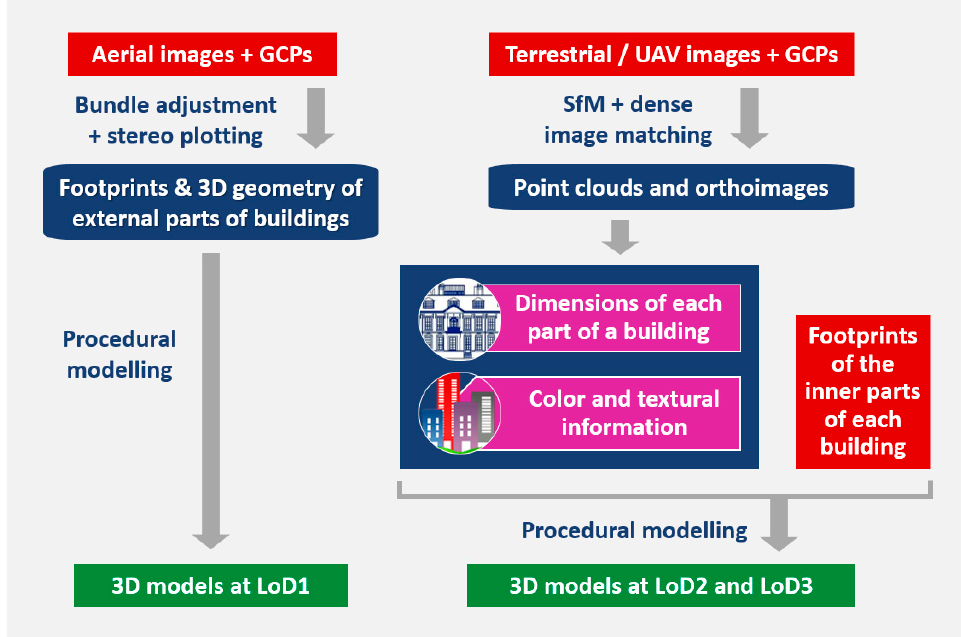
Figure 1. 3D modeling framework of the existing situation at various LoDs.